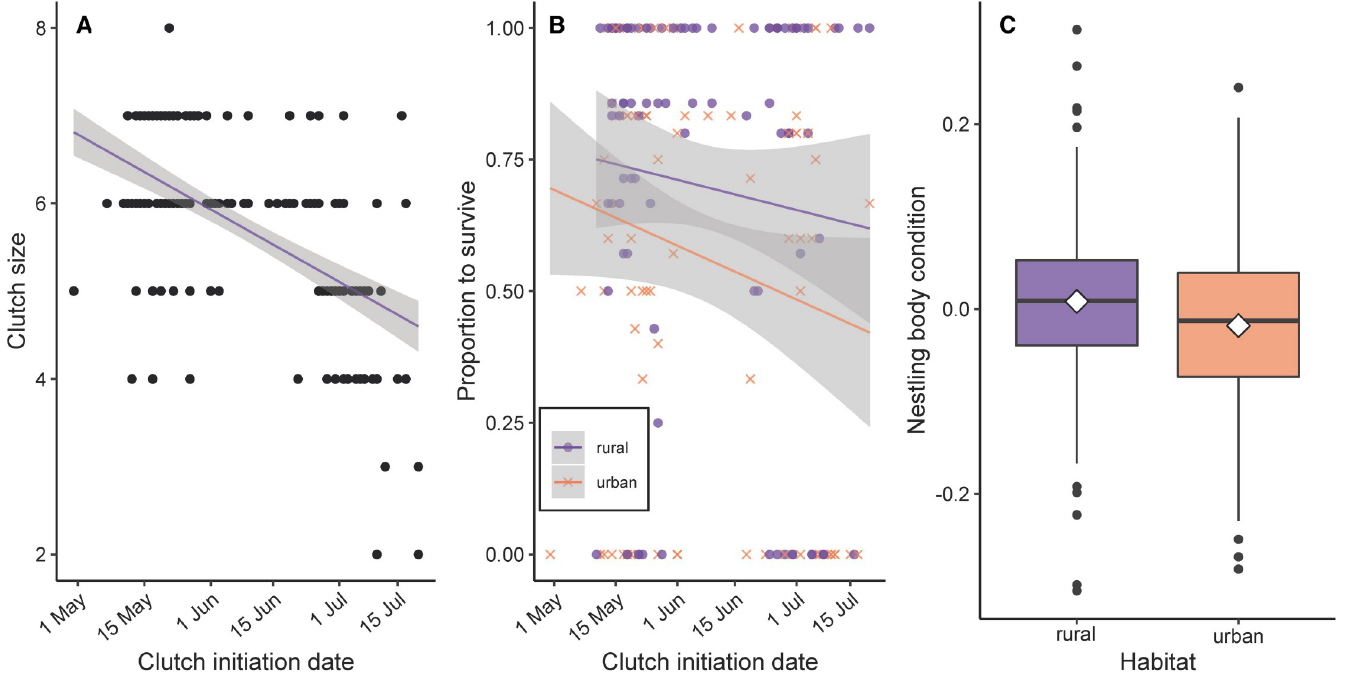
Fig 1. Reproductive success and nestling condition varied by date and habitat. Clutch sizes decreased with date, regardless of habitat (A). Nestling survival decreased with date, and this effect was more pronounced in the urban population (B). Regardless of hatch date, nestling condition was lower in urban habitat compared to rural (C; white diamonds with boxplot shows population mean).